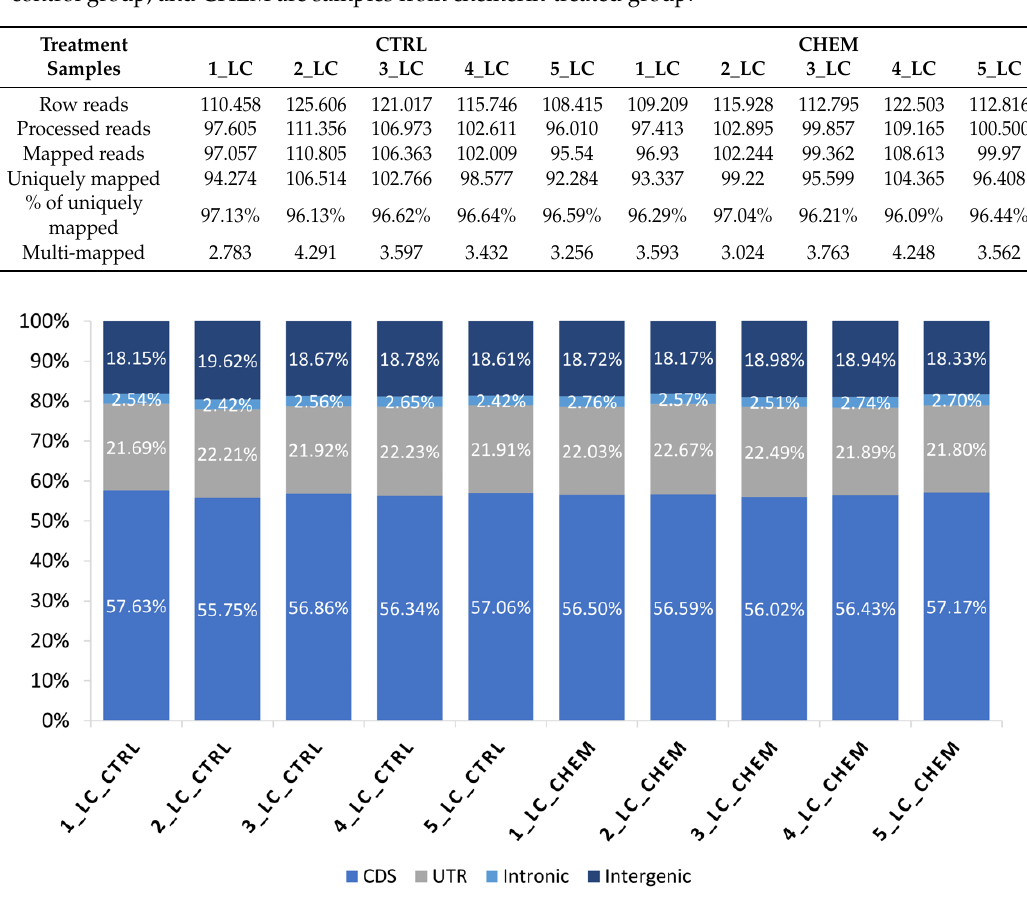
Figure 2. Percentage (%) of bases mapped to specific components of the pig reference genome among all samples: coding regions (CDS), untranslated regions (UTRs), intronic and intergenic regions. Genes 2020 , 11 , x FOR PEER REVIEW 7 of 18